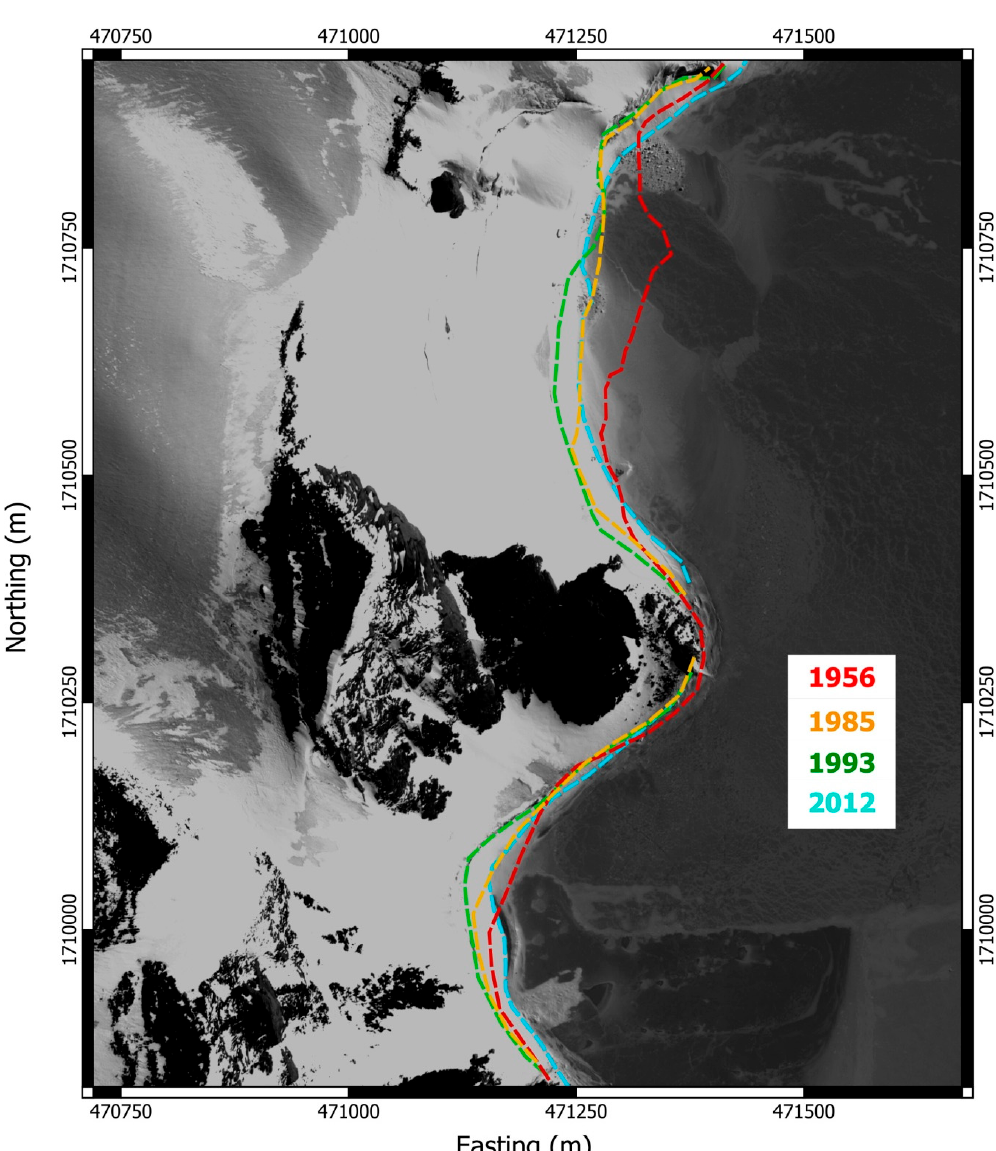
Figure 4. Ice front outline changes in Tethys Bay area from 1956 to 2012.